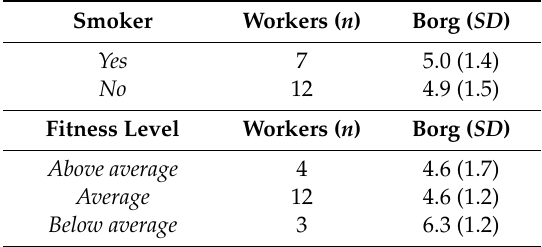
Table A3. Borg scale according to smoke status and fitness level.